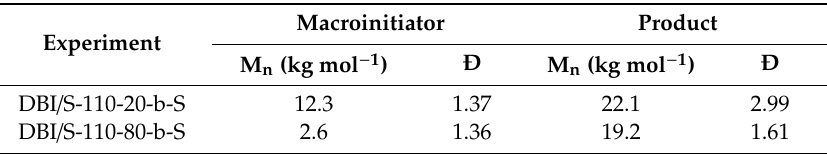
Table 5. Summary of chain extension reactions of dibutyl itaconate / styrene (DBI / S) macroinitiators with styrene at 110 ◦ C in 50 wt% dioxane